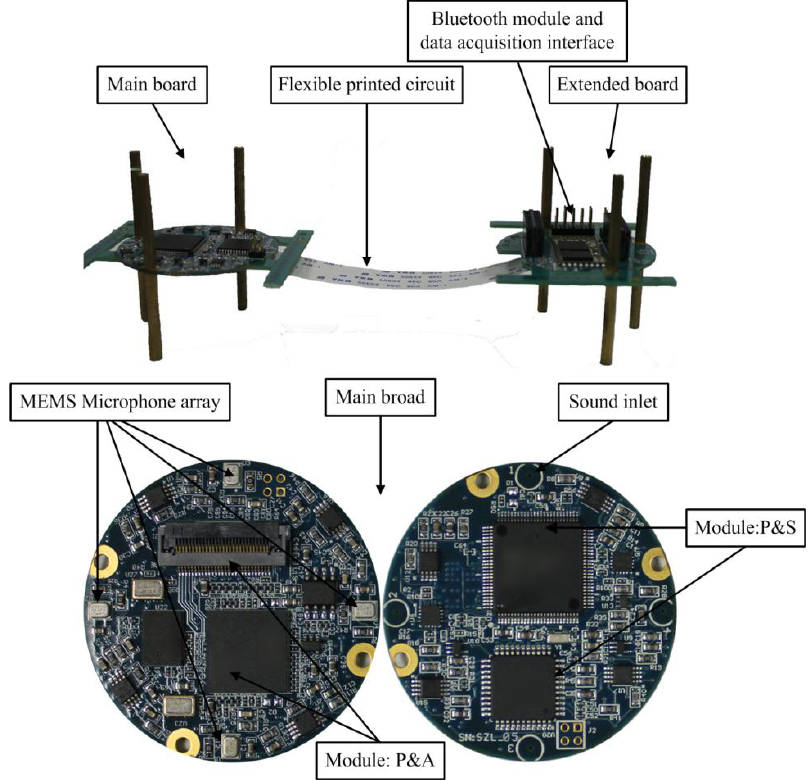
Figure 3. Photograph of the MEMS microphone array system, array aperture is 4 cm.